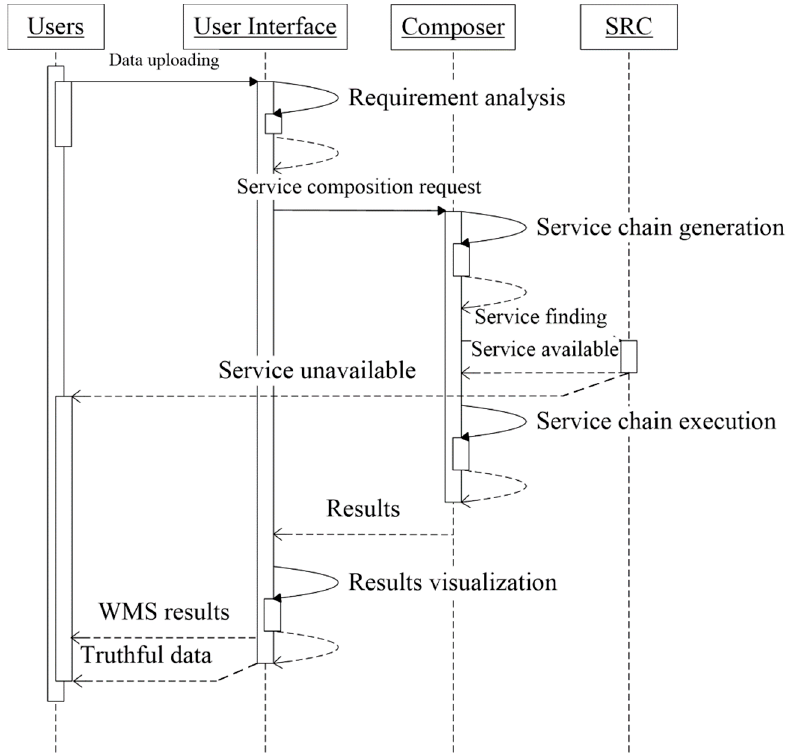
Figure 5. Unified modeling language (UML) sequence diagram of OGS-LCCD operation.